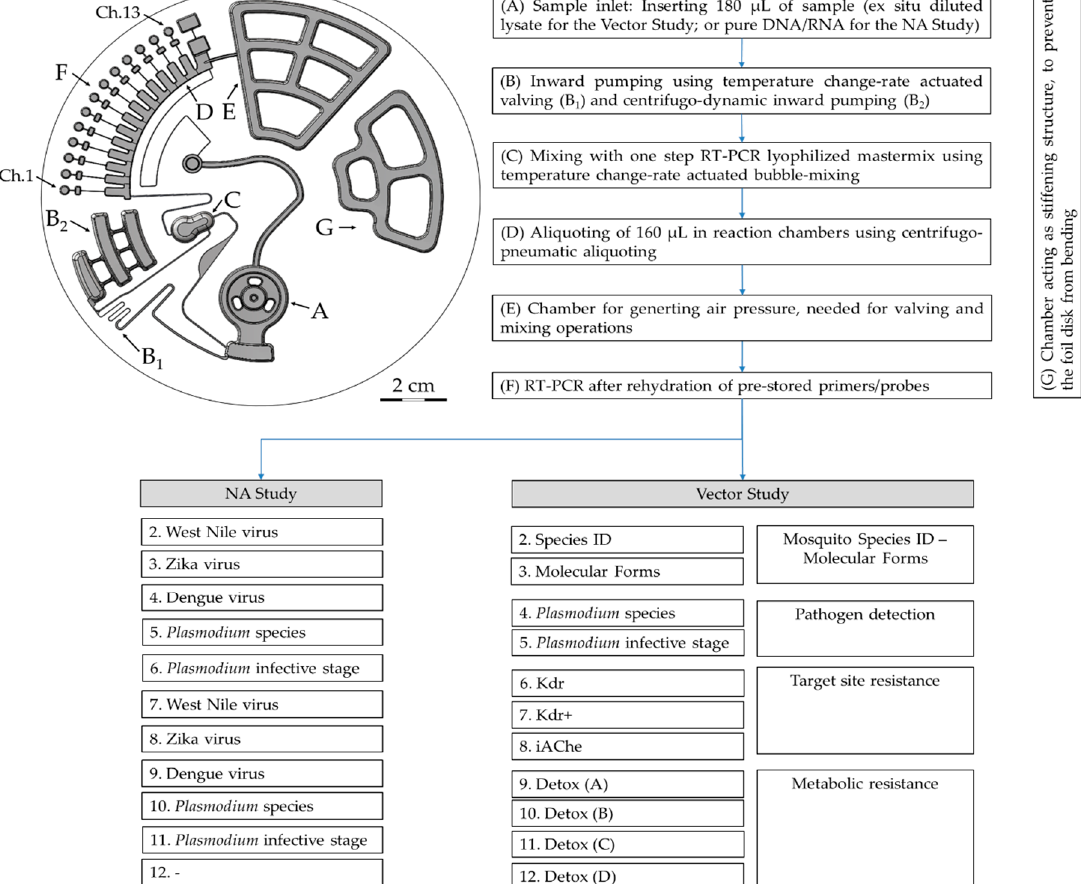
Figure 3. The VectorDisk design where the main unit operations are indicated ( A – F ). The structure G has the role of stiffening in order to prevent the foil disk from bending. The design was the same for both the Vector- and the NA-Studies. What differed was the type of inserted sample, and the assay panel. ‘Ch.1, 2, …’ refers to the VectorDisk reaction chambers.